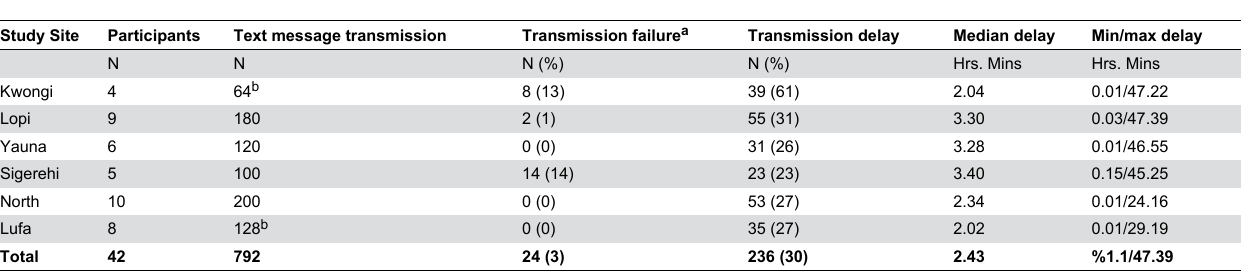
Table 2. Overview of text message